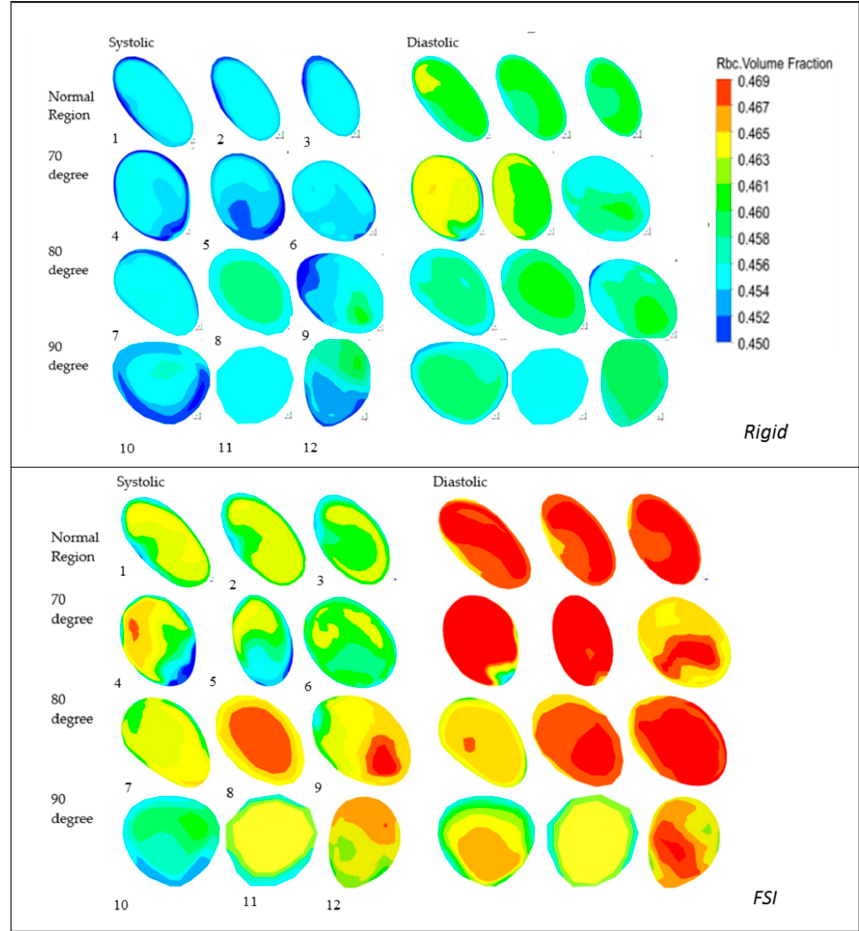
Figure 10. RBC volume fraction across the stenosis with degrees: 70%, 80% and 90% in left coronary artery (LCA) during systolic and diastolic phase of cardiac cycle within a rigid model (top) and FSI model (bottom) on planes 1–12.